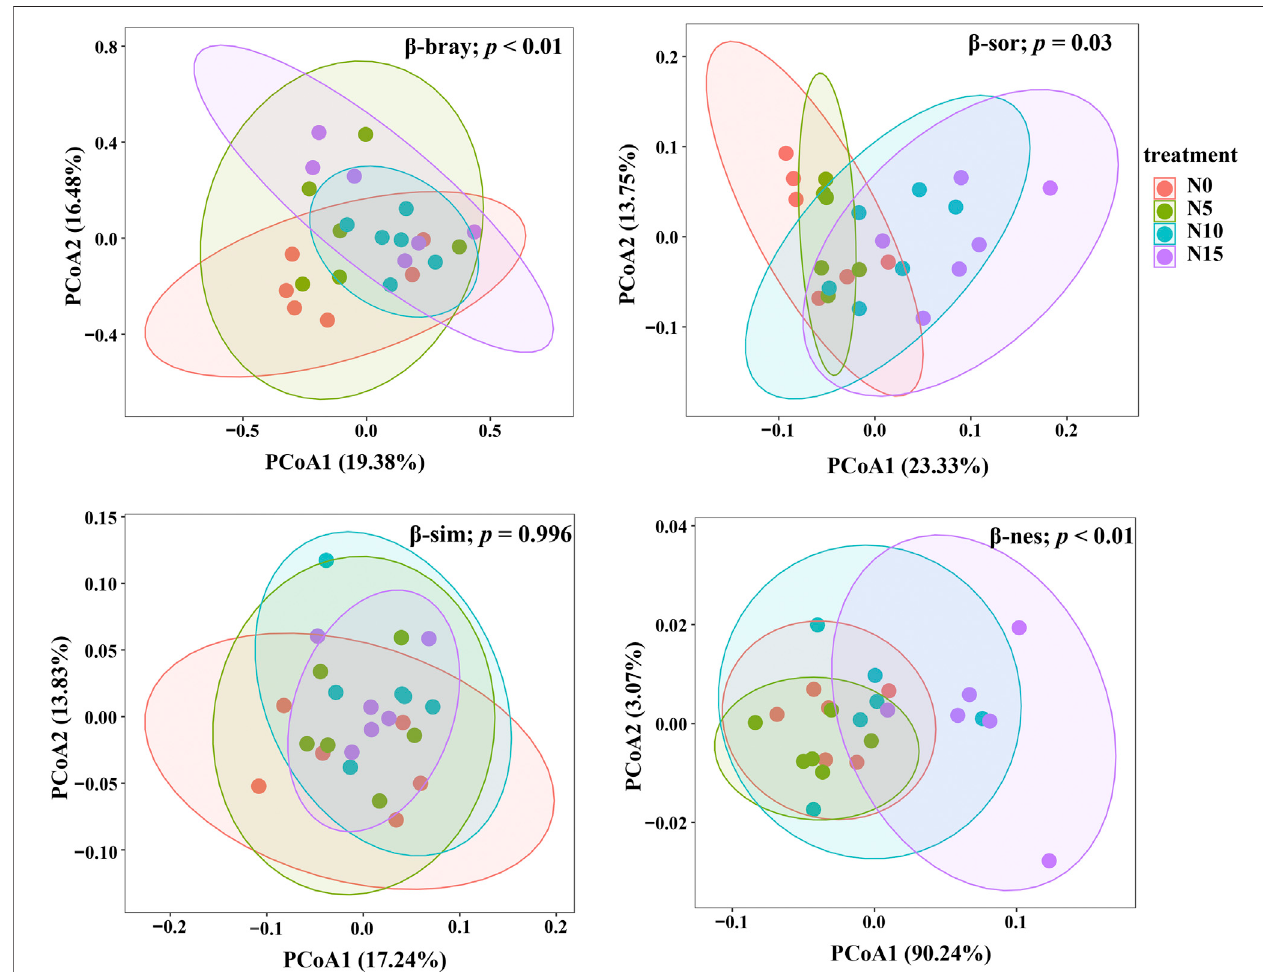
FIGURE4| Principalcoordinateanalysis(PCoA)byPERMANOVAshowingtheassociationofsoilAMFcommunitydissimilaritiesalongandwithinnitrogenaddition treatments. Signi fi cance of the Bray – Curtis ( β -bray; abundance-weighted), Sørensen ( β -sor; presence/absence-based), partitioned Simpson ( β -sim), and nestedness ( β -nes) dissimilarities with nitrogen addition are shown with p values ( p ≤ 0.05 means a signi fi cant effect).